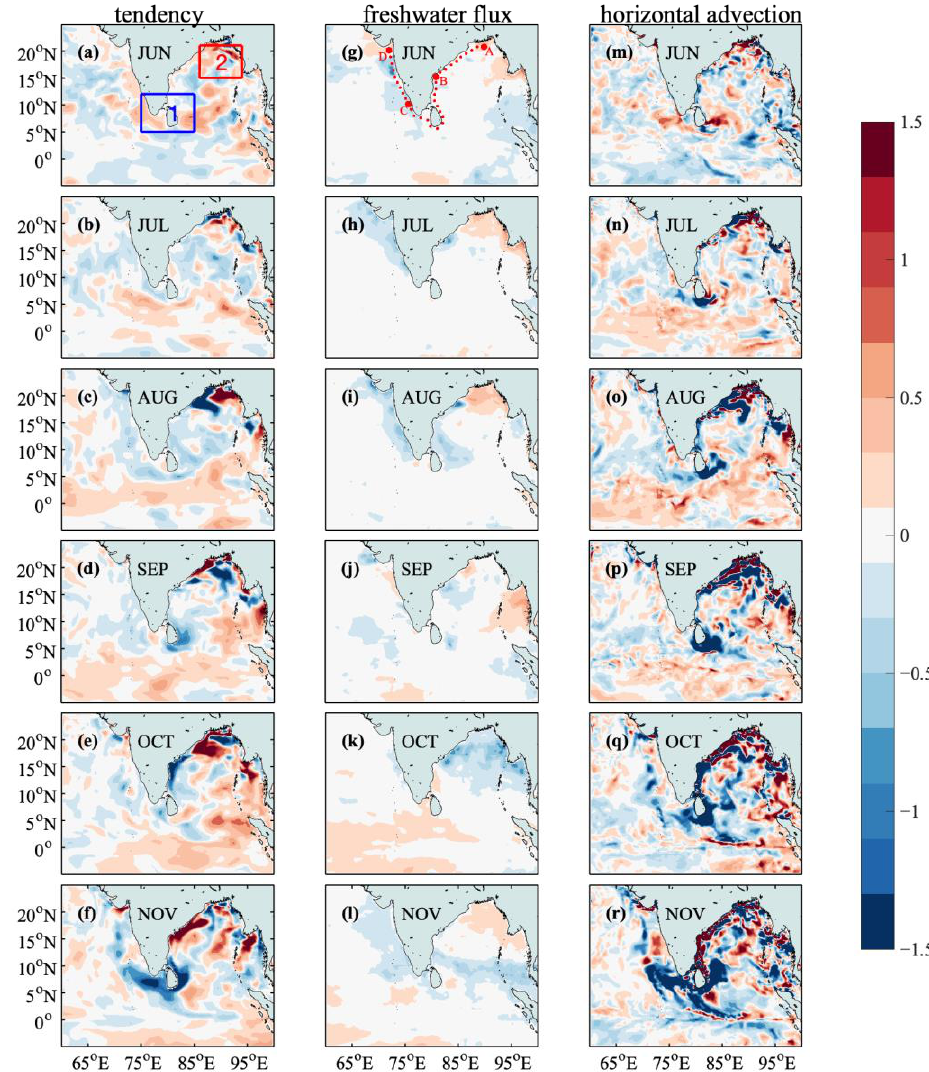
Figure 5. Monthly mixed layer anomalous salt budget in 2010 (shaded; psu/month), including the tendency term ( a – f ), anomalous local freshwater flux term ( g – l ) and horizonal advection term ( m – r ). The blue box indicates region 1 around Sri Lanka (75 – 85°E, 5 – 12°N), and the red box indicates region 2 in the northern BoB (86 – 94°E, 15 – 21°N). The red dots in ( g ) indicate the track of low-salinity water.